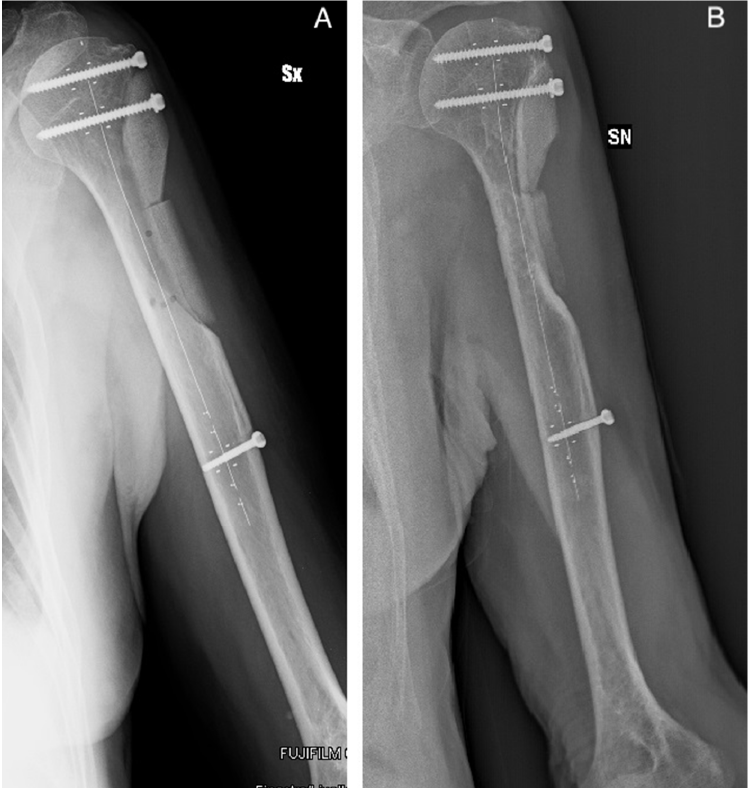
Figure 3. Patient 18. Radiological control after one month from Myxofibrosarcoma excision with ( A ) lateral proximal humerus cortical resection and reconstruction with two SB blocks. ( B ) The radiograph on the right shows a line of radiolucency and a partial resorption of the lowest block due to the incomplete coverage of the graft and its isolation from the soft tissues. Abbreviations: SX and SN stand for Left.